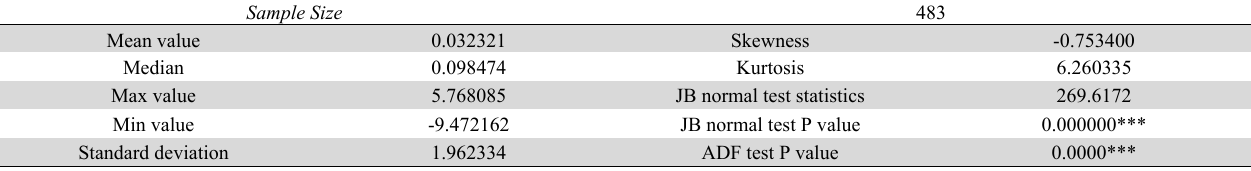
Table of basic statistical characteristics of relative volatility time sequence (RT) of deformed steel bars futures price Sample Size